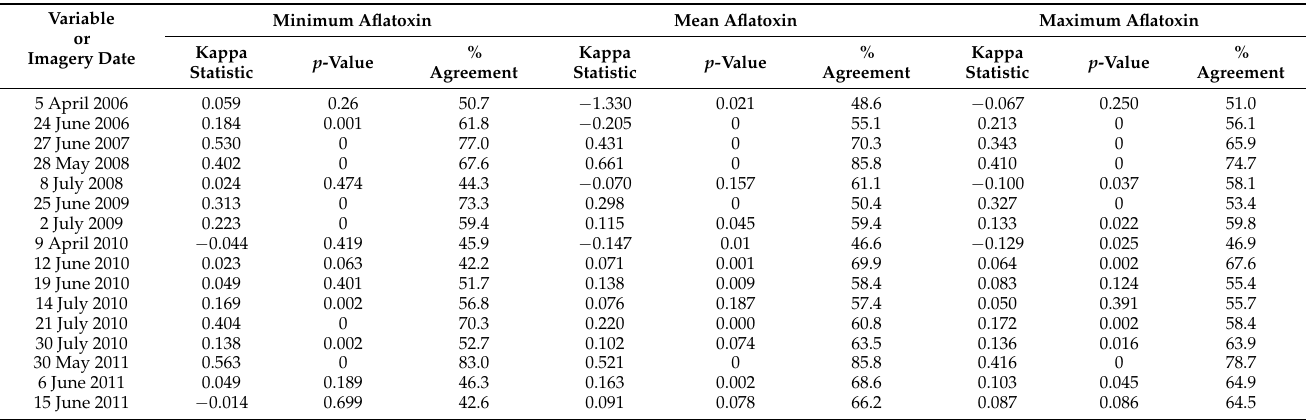
Table 5. Kappa statistic and percent agreement results for comparison of K -means classifications based on kriged minimum, mean and maximum aflatoxin values and imagery (NDVI and Thermal IR) from various months in